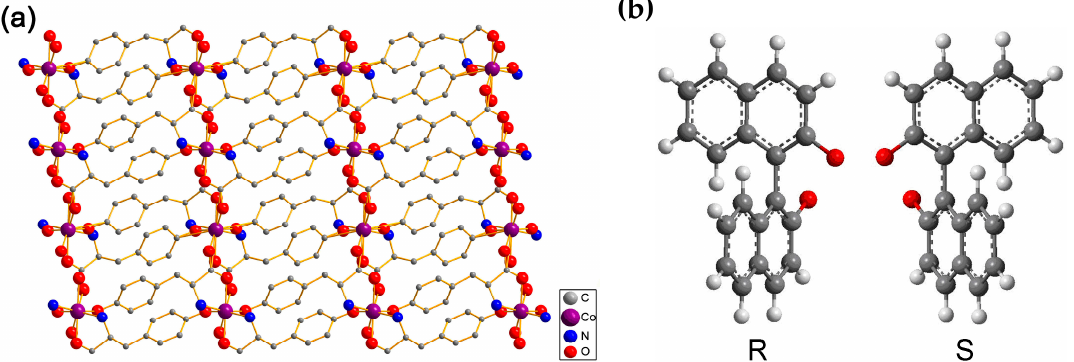
Figure 1. ( a ) 2D crystal structure of the chiral metal-organic framework (MOF), [Co( L -tyr)] n ( L -tyrCo); ( b ) the structures of 1,1 ′ -bi-2-naphthol enantiomers.